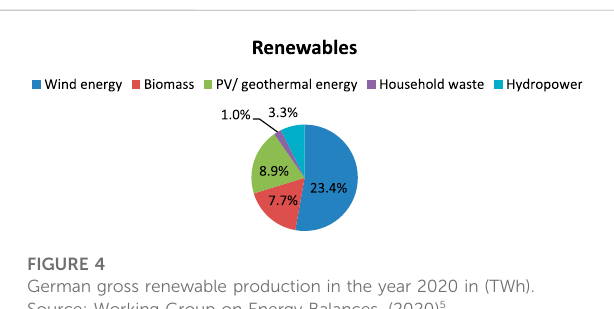
FIGURE 4 German gross renewable production in the year 2020 in